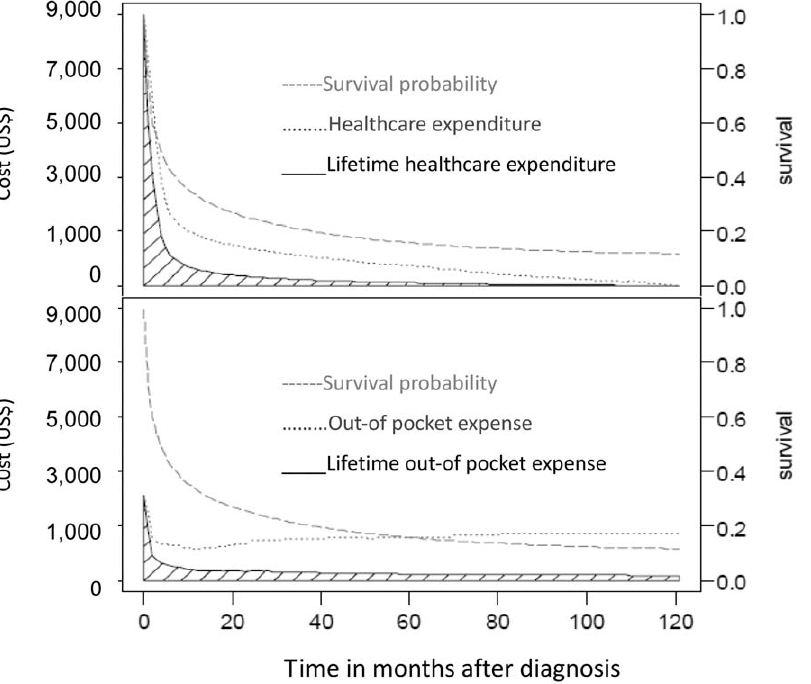
Figure 3. The average lifetime healthcare expenditure paid by the National Health Insurance (NHI) for patients undergoing PMV. (prolonged mechanical ventilation) was calculated by multiplying the monthly average paid by the NHI (N=50,481) with the corresponding survival probability and then summed up throughout life, as indicated by the shaded areas of the upper panel. The lifetime out-of pocket expense for PMV patients was obtained by multiplying the monthly average out-of pocket expense (estimated by kernel smoothing method on a convenient sample of 165 patients) with the corresponding survival probability and then summed up (shaded areas of the lower panel). The expected lifetime cost of a PMV patient is the total sum of these two shaded areas.